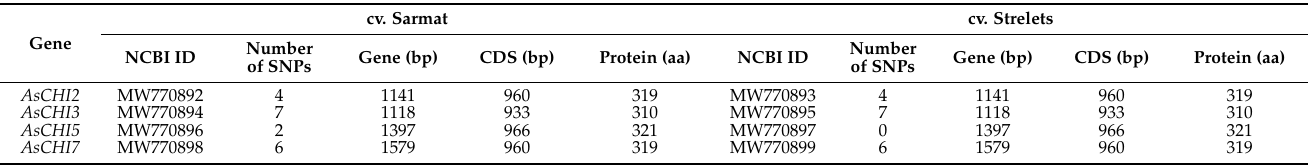
Table 4. Characteristics of AsCHI homologous genes identified in Allium sativum cv. Sarmat and Strelets . CDS: coding sequence. cv. Sarmat cv. Gene